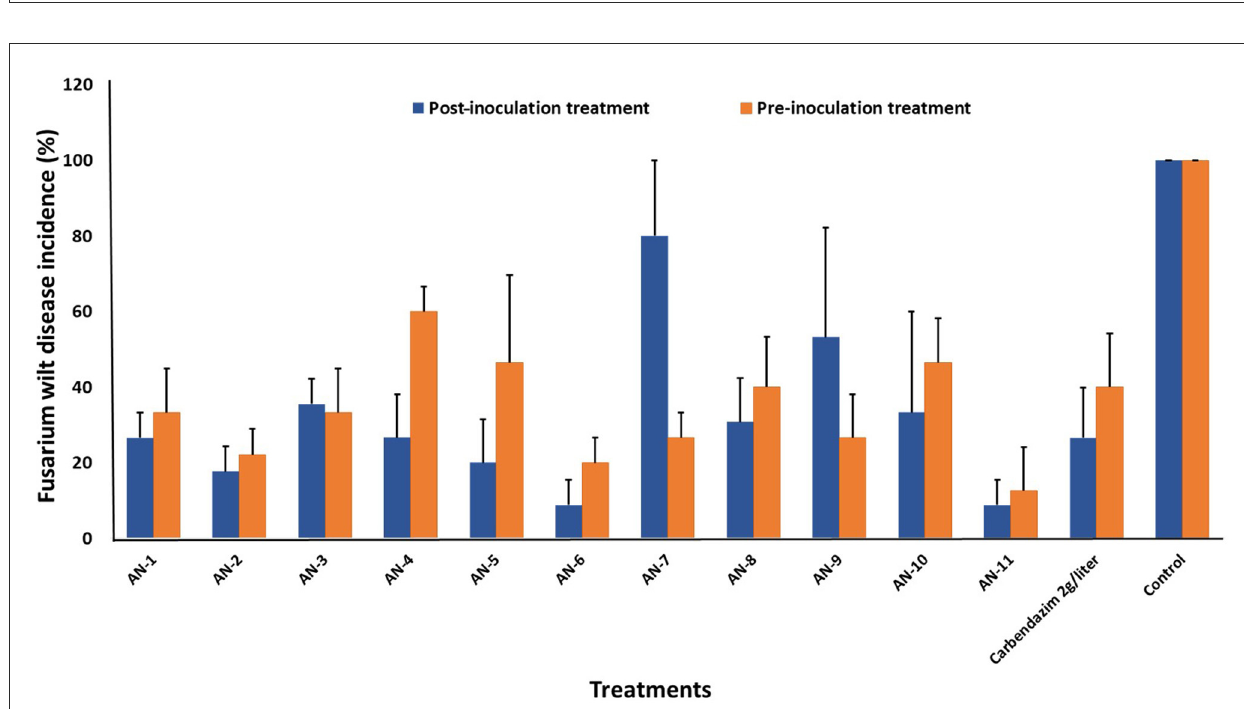
FIGURE5 Effect of A. niger strains on percent wilt incidence of guava seedlings during post and pre-inoculation treatment of F. oxysporum f. sp. psidii (FOP) under greenhouse conditions. Bars represent the mean values obtained in three independent repeats and standard error is indicated by error bars. AN represents A. niger